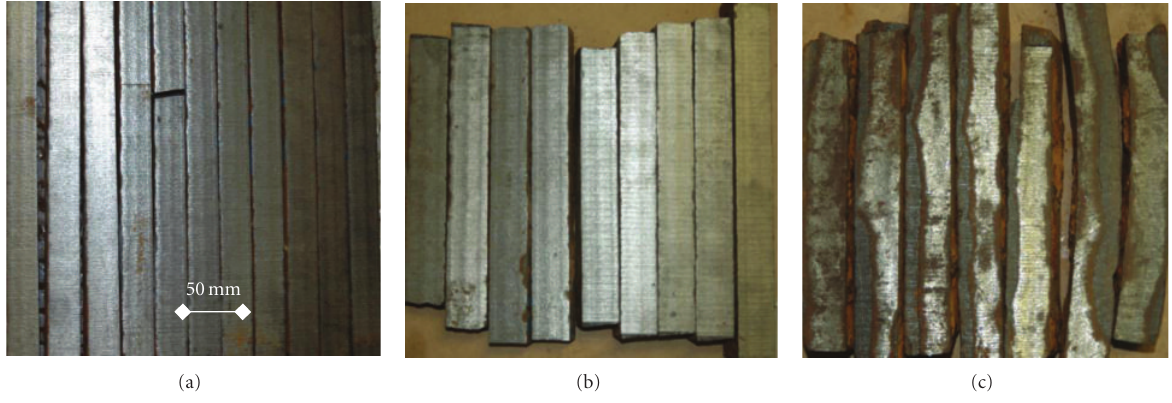
Figure 1: Test specimens cut from (a) Pipe 1, (b) Pipe 2, and (c) Pipe 3. Table 2: Graphite flake